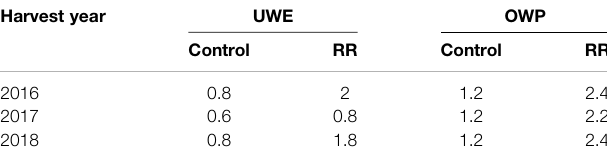
TABLE 4 | Annual water productivity at UWE and OWP (g m − 2